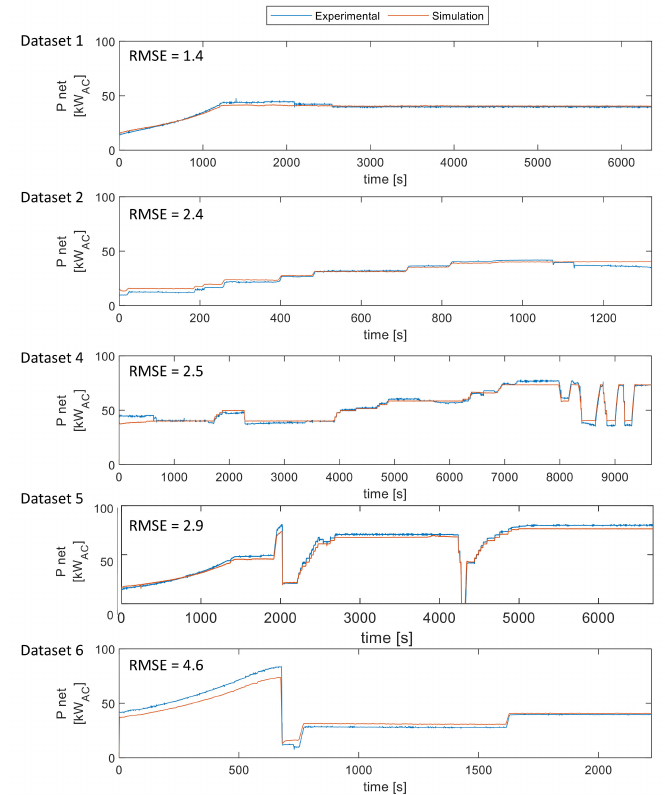
Figure 3. Comparison of experimental and simulated values of net